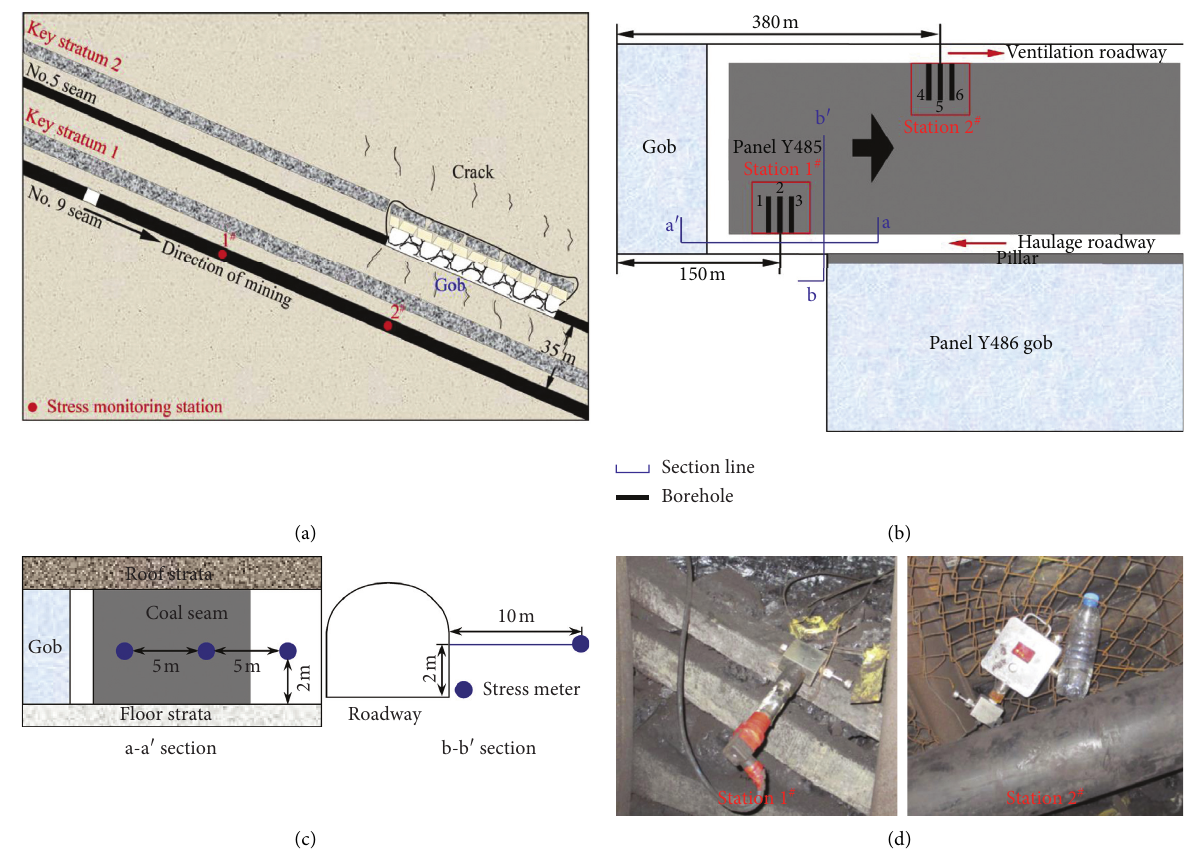
Figure 3: Installation of borehole stress meters. (a) Section location of stress monitoring stations. (b) Planar location of stress monitoring stations. (c) Layout of borehole stress meters; (d) borehole stress meters.